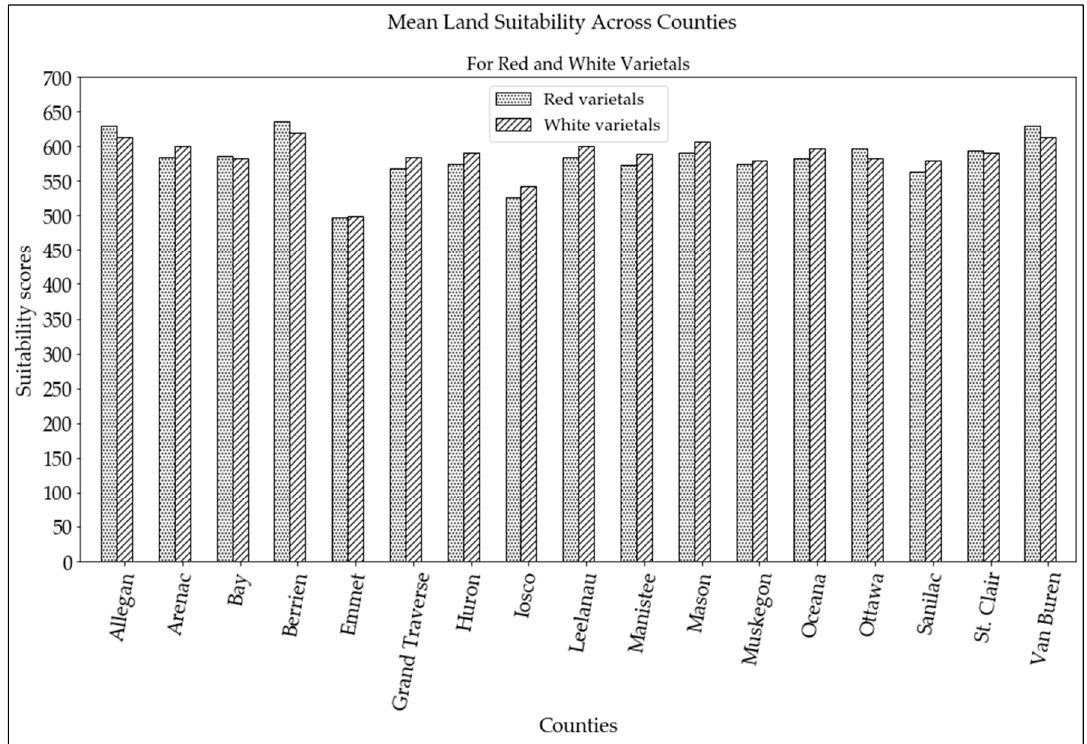
Figure 7. Average land suitability scores for red and white vinifera production.